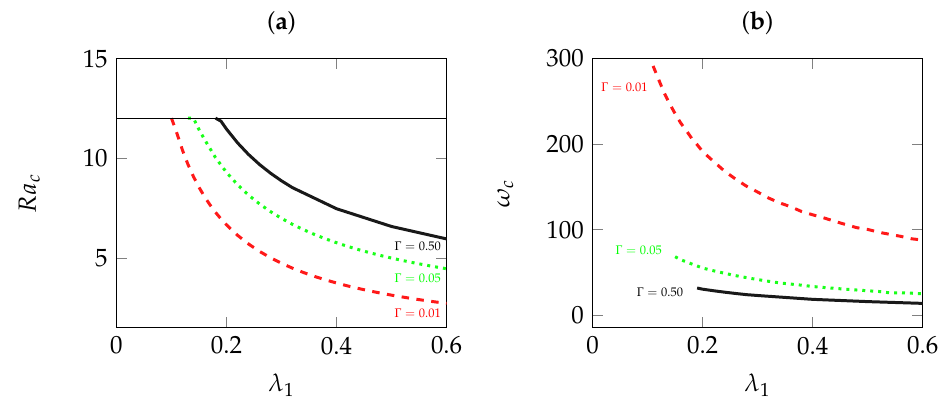
Figure 4. ( a ) Critical Rayleigh number and ( b ) critical frequency at the onset of oscillatory convection as a function of λ 1 for different values of Γ . The line Ra = 12 in (a) corresponds to the critical Rayleigh number at the onset of stationary convection.